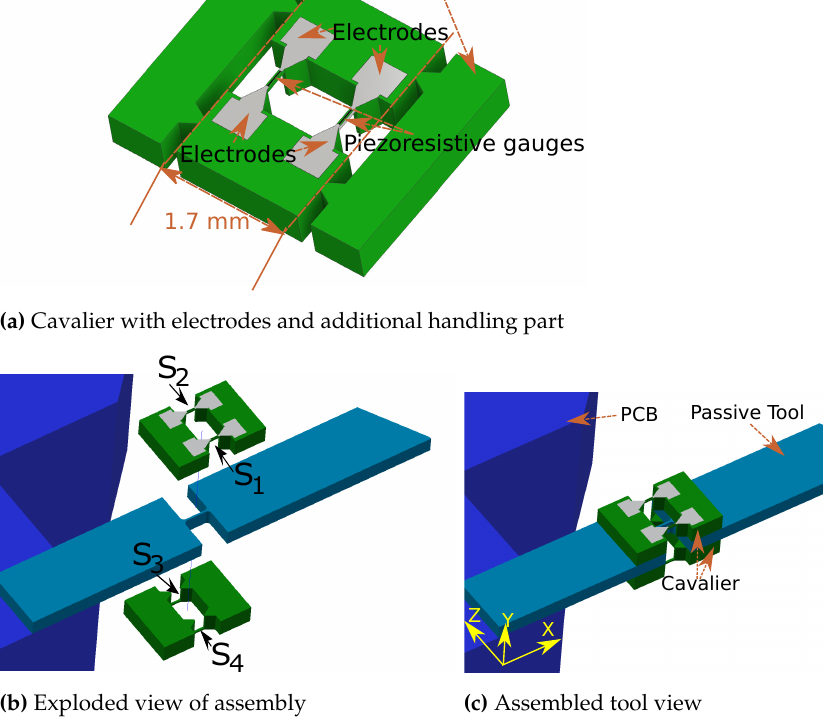
Figure 2. Proposed design of the sensing